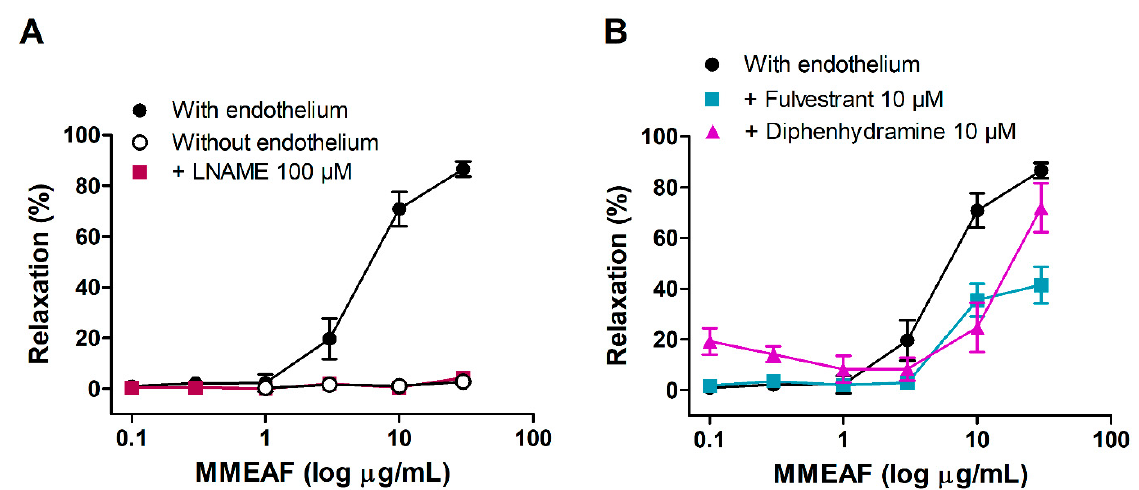
Figure 5. In ( A ), concentration–response curves for MMEAF in aorta with endothelium, in the absence and presence of L-NAME (100 µ M), and in aorta without endothelium. In ( B ), concentration–response curves for MMEAF in the presence of fulvestrant (10 µ M) or diphenhydramine (10 µ M). Results are mean ± S.E.M of 5-7 experiments.